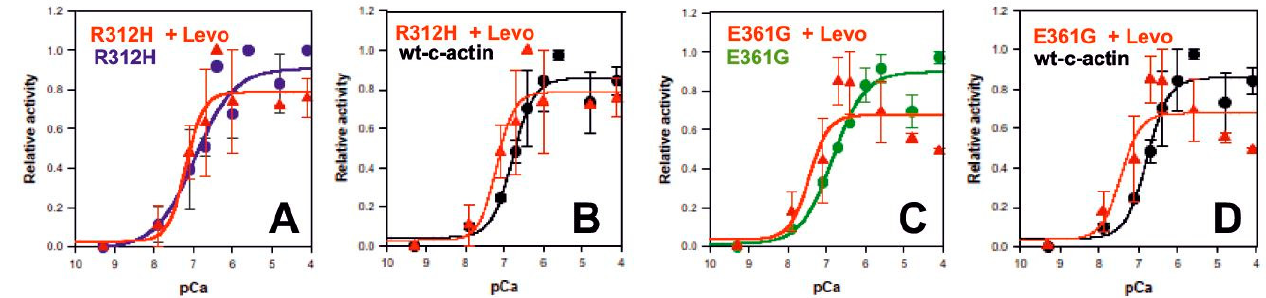
Figure 7. Influence of levosimendan on the stimulation of myosin-S1 by the DCM c-actin mutants. The Ca 2+ -concentration dependence of myosin-S1 ATPase stimulation by the DCM mutants p.R312H and p.E361G were determined in the presence and absence of 20 μ M levosimendan by the enzyme-linked optical assay using 1 μ M skeletal muscle myosin-S1 and 1.5 μ M of the polymerized c-actin mutants decorated with cTm/cTn at a molar ratio to the polymerized c-actin mutants of 6:1:1. ( A ): p.R312H ± Levo; ( B ): p.R312H ± Levo and wt c-actin; ( C ): p.E361G ± Levo; ( D ): p.E361G ± Levo and wt c-actin. Data are given as mean values ± SEM. Abscissa gives pCa-values (-log molar Ca 2+ - concentration). All measurements were performed in triplicate. Table 4. Parameters of the myosin-S1 ATPase stimulation by the DCM c-actin mutants p.R312H and E361G in the presence of 20 μ M Levosimendan. Mean values of triplicate experiments. Variations are given as SEM.